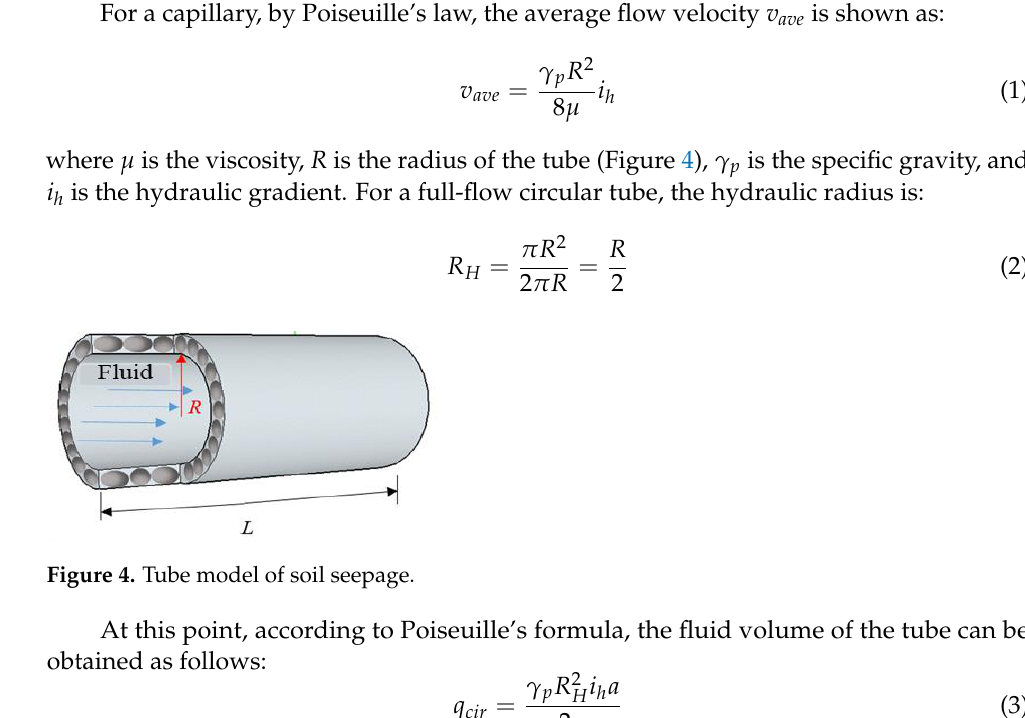
Figure 5. Influence of absorbed water or DEL.